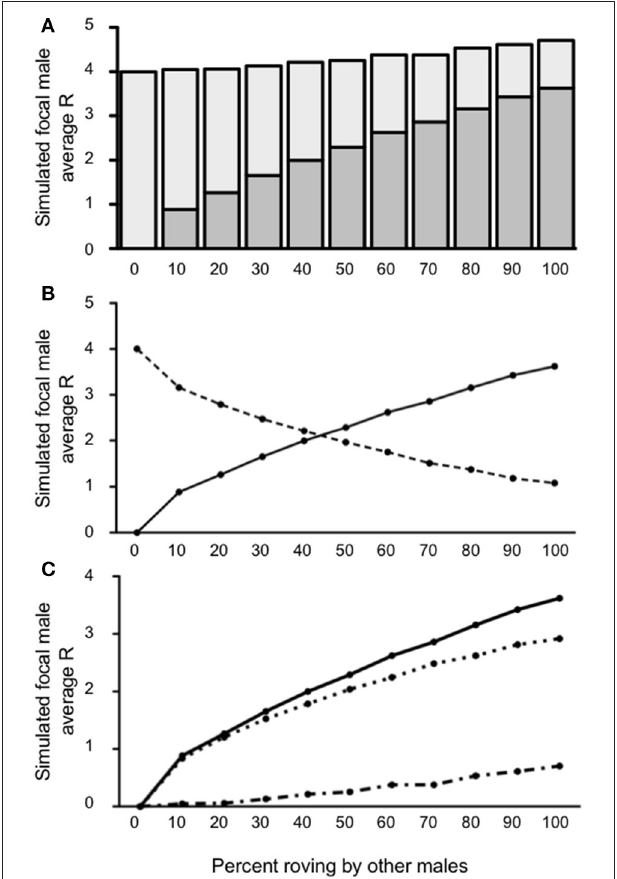
FIGURE 6 | Reproductive success for simulated roving focal male in Condition 3 at pair population 1,000 with 10% wandering and unpaired females. (A) Mean reproductive success (R) obtained by the simulated roving focal male at each percentage of roving in the population, split between R gained via extra-pair copulations (EPC; dark gray) and intra-pair copulations (IPC; light gray). (B) Average R gained via EPCs (solid line) and IPCs (dashed line) by the simulated roving focal male as the percentage of roving in the population increases. (C) Average R gained via EPCs ( E , solid line), average R lost via cuckolding ( C , dotted line), and total change in R ( 1 R, dash-dotted line) for the simulated roving focal male as the percentage of roving in the population